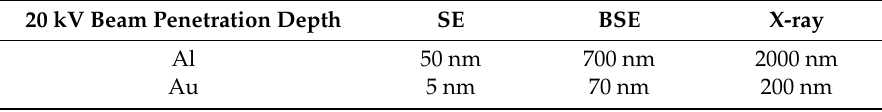
Table 2. Penetration depth of SE, BSE and EDS in Al and Au with a 20 kV beam.